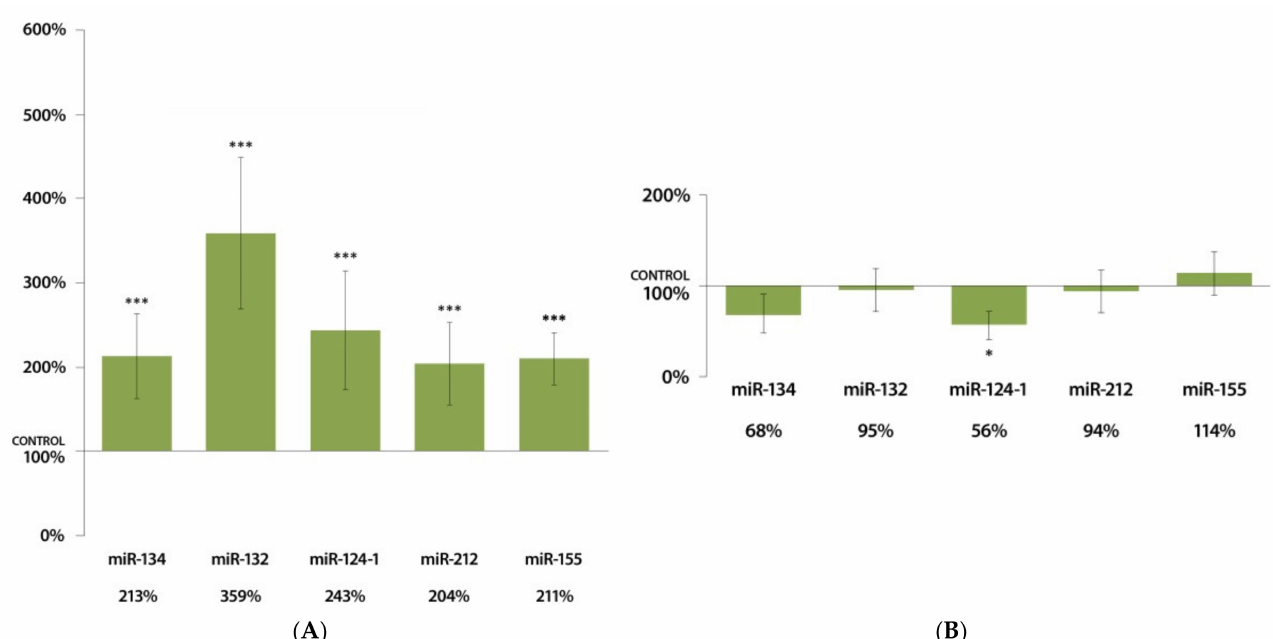
Figure 1. Expression results of miR-134, miR-132, miR-124-1, miR-212, and miR-155 in the liver of ( A ) female and ( B ) male CBA/Ca mice 24 h after DMBA treatment, compared to non-treated mice (100%) (* p < 0.05; *** p < 0.001).